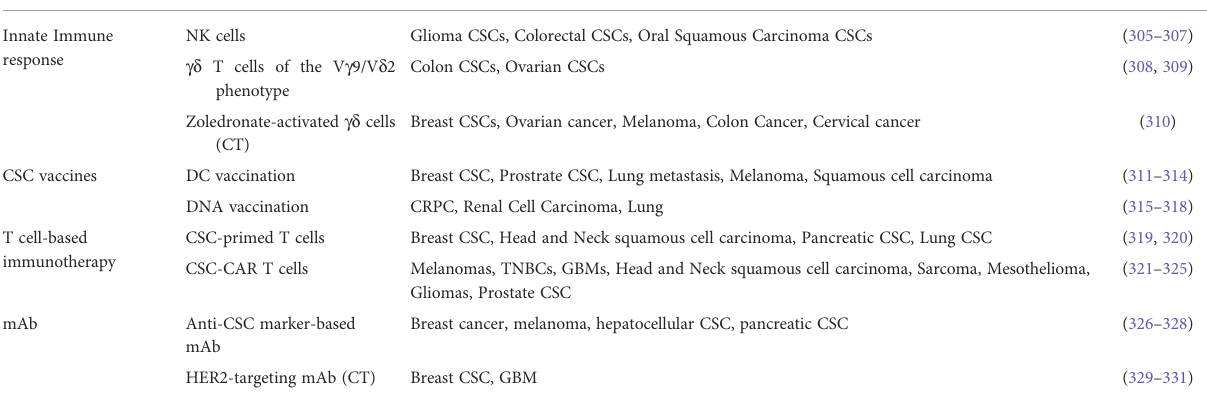
TABLE 2 A summarized form of immunotherapies (*CT = Combinational